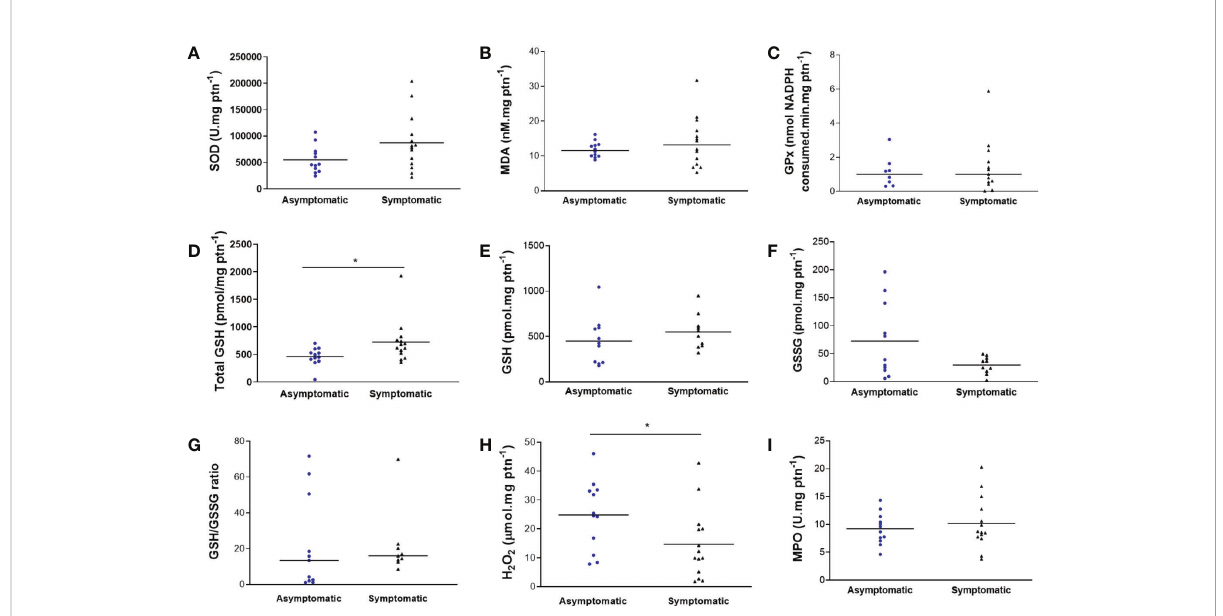
FIGURE 2 Biomarkers of oxidative stress in colostrum of symptomatic (n=14) and asymptomatic (n=12) for SARS-CoV-2 of lactating women, during pregnancy. (A) Concentration of SOD (U mg protein -1 ). (B) Concentration of MDA (nM mg protein -1 ). (C) Concentration of GPx (nmol NADPH consumed min mg protein -1 ). (D) Concentration of total GSH (pmol mg protein -1 ) (* p = 0.0202). (E) Concentration of GSH (pmol mg protein -1 ). (F) Concentration of GSSG (pmol mg protein -1 ). (G) Concentration of GSH/GSSG ratio. (H) Concentration of H 2 O 2 (µmol mg protein -1 ) (* p = 0.0422). (I) Concentration of MPO (U mg protein -1 ). Data are presented as median and 95% CI. *indicates a statistical difference, comparing Asymptomatic versus Symptomatic. Mann – Whitney test: p <